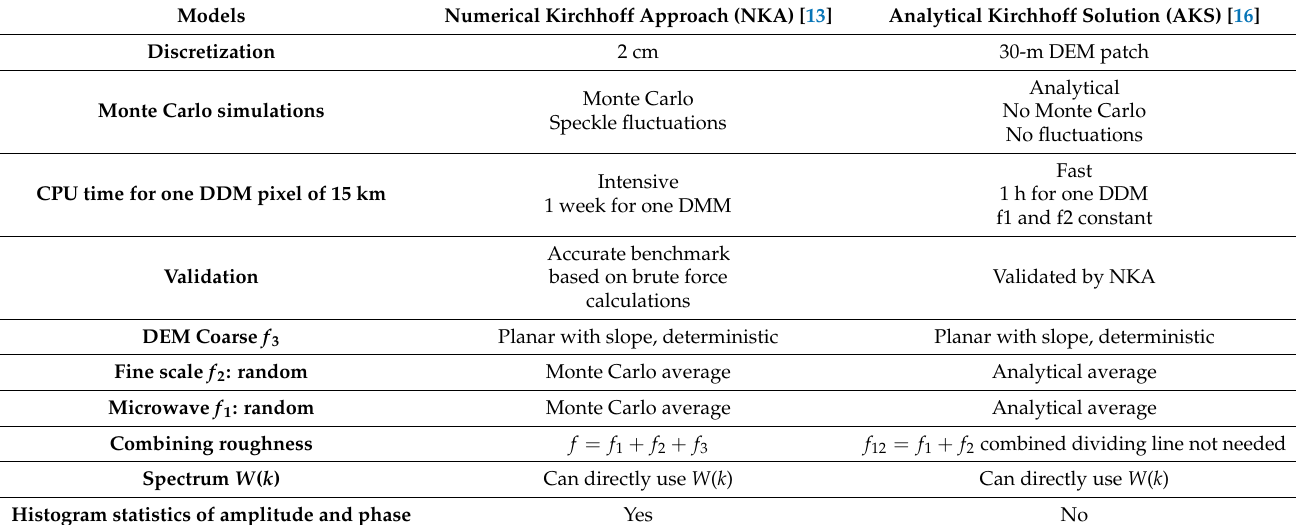
Table 5. Summary of the two Kirchhoff